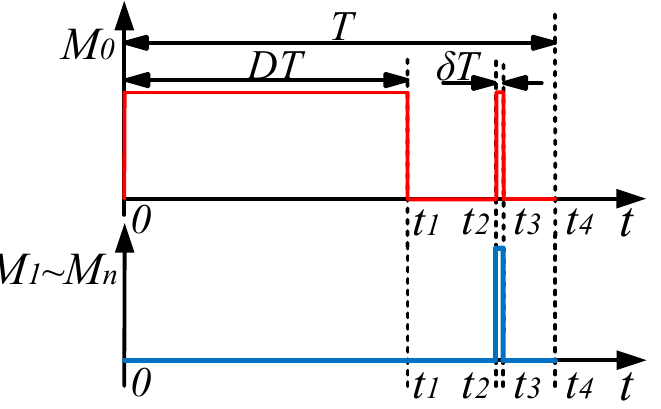
Figure 2. Switch on/off timing sequence.